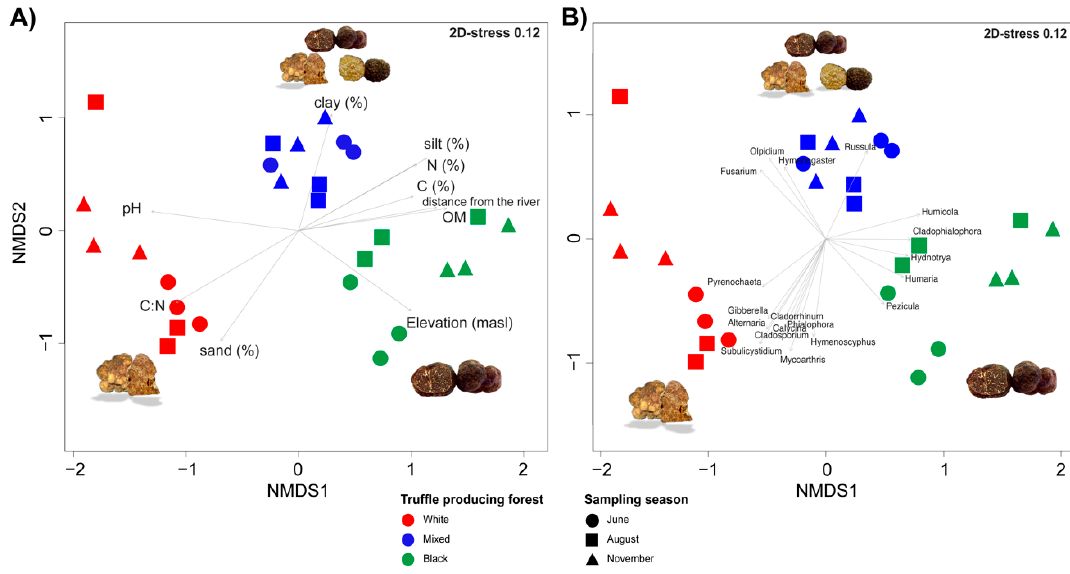
Figure 4. Two-dimensional non-metric multidimensional scaling (2D-NMDS) ordination of root-associated mycobiome of white (red), mixed (blue) and autumn black (green) truffle-producing forests in Serbian riparian forests in three different sampling times (June (circles), August (squares), and November (triangle). The NMDS ordination was fitted with soil physiochemical parameters ( A ) and with fungal genera ( B ) (only significant soil physiochemical parameters and fungal genera p < 0.05 are shown). Goodness-of-fit statistics ( R 2 ) for factors fitted to the two-dimensional non-metric multidimensional scaling (2D-NMDS) ordination of root-associated fungal communities in di ff erent tru ffl es producing forest types in Serbian riparian forests. p values: *** = p <